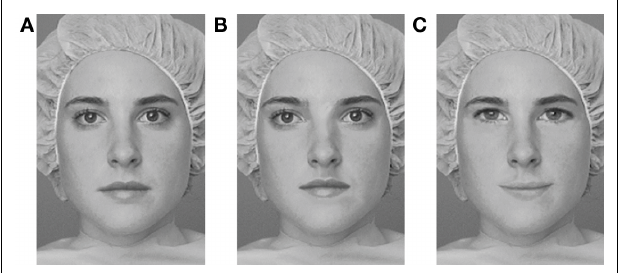
FIGUREA1 | Examples of stimuli used in the Jane task: (A) original face; (B) spacing changes; (C) feature changes. In the experimental task, faces were presented both upright and